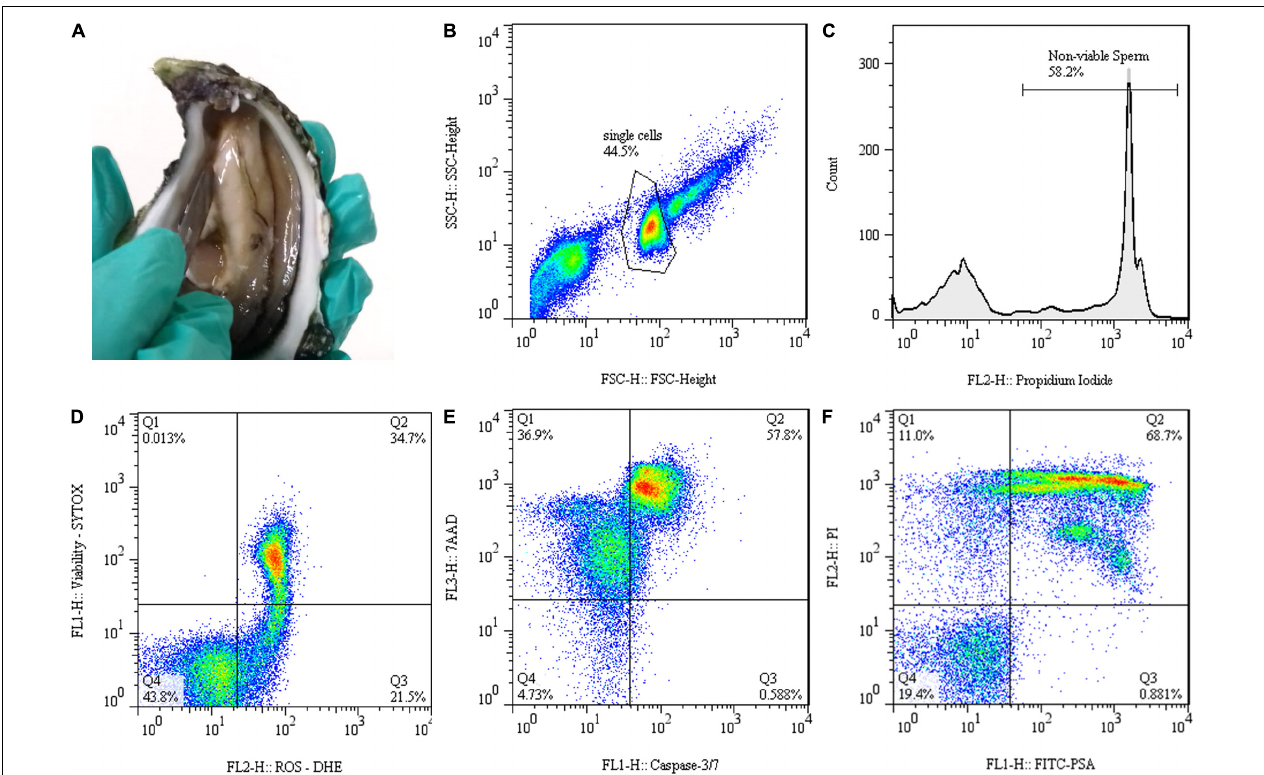
FIGURE 1 | Gamete collection and flow cytometry data representation of Crassostrea angulata ( C. angulata ) thawed sperm: (A) Gonadal incisions to collect sperm. (B) Forward scatter (FSC-H) and side scatter (SSC-H) dot plot used to identify sperm population. (C) Histogram displaying propidium iodide (PI) fluorescence signal for identifying population with injured membrane. (D–F) Dot plots representing techniques of dual staining to detect (D) reactive oxygen species (ROS) by using the fluorescent probes dihydroethidium (DHE) and SYTOX R (cid:13) Green Nucleic Acid Stain (SYTOX) [dead cells with undetectable levels of ROS (Q1); dead cells with detectable levels of ROS (Q2); live cells with detectable levels of ROS (Q3); live cells with undetectable levels of ROS (Q4)], (E) caspase activity applying caspase-3/7 reagent with 7-aminoactinomycin D (7-AAD) [necrotic (Q1), late apoptotic (Q2), early apoptotic (Q3) and live (Q4) cells] and (F) acrosome integrity by fluorescein isothiocyanate-labeled Pisum sativum agglutinin (FITC-PSA) and PI labeling [dead cells, acrosome intact (Q1); dead cells, acrosome reacted (Q2); live cells, acrosome reacted (Q3); live cells, acrosome intact